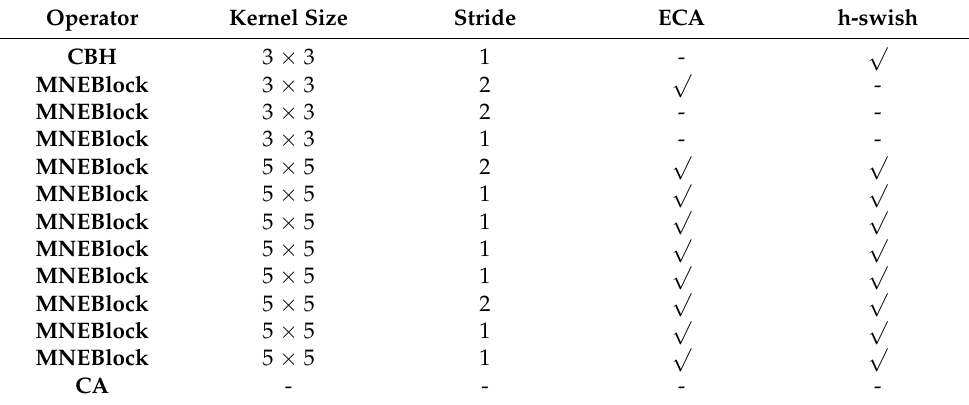
Figure 2. The framework of YOLOv5-MNE (( a ) the framework of YOLOv5-MNE; ( b ) part of the framework of MNEBlock). Table 1. Details on the YOLOv5-MNE backbone